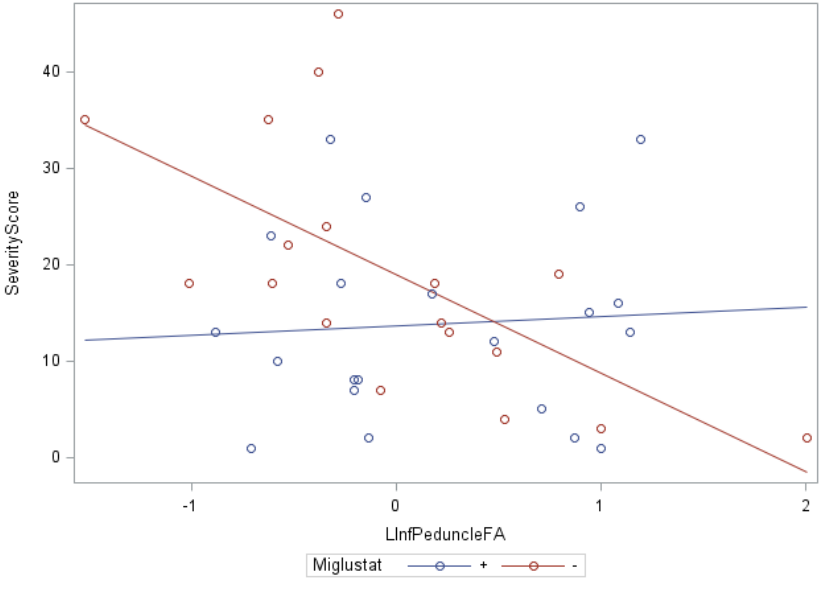
Figure 1. ANCOVA of NNSS, miglustat therapy, and FA of the left inferior peduncle.